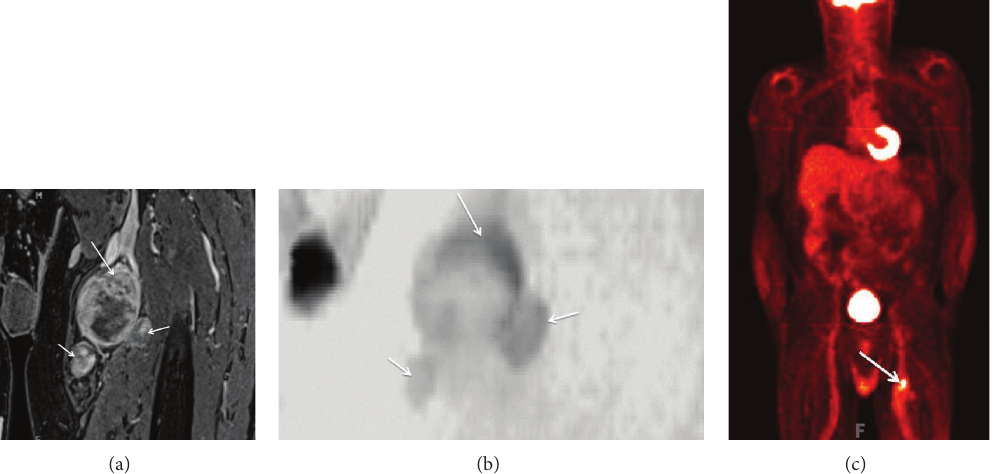
Figure 10: (a) Anatomic MRN, functional MRN, and F-18 FDG-PET correlation-Coronal fat suppressed postcontrast 3D T1W image of a biopsy proven malignant peripheral nerve sheath tumor shows the solid heterogeneous enhancement along the superior aspect of the lesion (large arrow). Notice additional smaller benign PNSTs in this case of neurofibromatosis type I (small arrows). (b) Anatomic MRN, functional MRN, and F-18 FDG-PET correlation-Coronal MIP reconstruction (inverted grey scale contrast) from single shot DTI ( 𝑏 values 0, 800, 1000s/mm 2 , 12 directions) image shows the lowest ADC values ( 0.7×10 −3 mm 2 /s) along the superior aspect of the lesion, which was targeted forthesuccessfulbiopsy(largearrow). NoticethattheadditionalsmallerbenignPNSTsshowhigherADCvalues(smallarrows). (c)Anatomic MRN, functional MRN, and F-18 FDG-PET correlation-Coronal F-18 FDG image shows high SUV max value (4 increased to 6 on delayed image) in the corresponding superior aspect of the